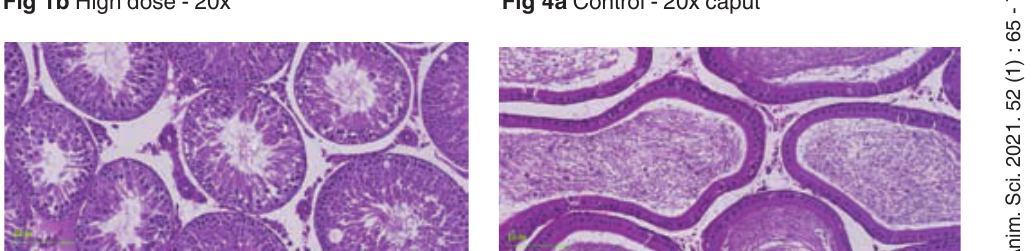
Fig 2 - 20x Sertoli Cell Vacuolation and Partial Germ Cell Loss